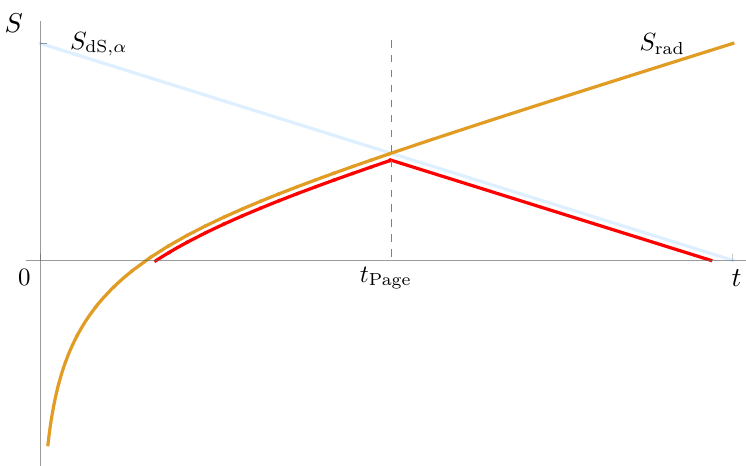
Figure 7 . The decreasing de Sitter entropy (light blue) and the radiation entropy (orange) as collected inside the static patch. We took the cut-off (cid:15) such that the complement of the radiation entropy overlaps at early times with the decreasing de Sitter curve. To plot we set ‘ = G = 1 ; then, (cid:15) = sinh( π ) ‘e − π . Note that the negative entropy values at early times are an effect of the finite cut-off and indicate that the computation should not be trusted before this